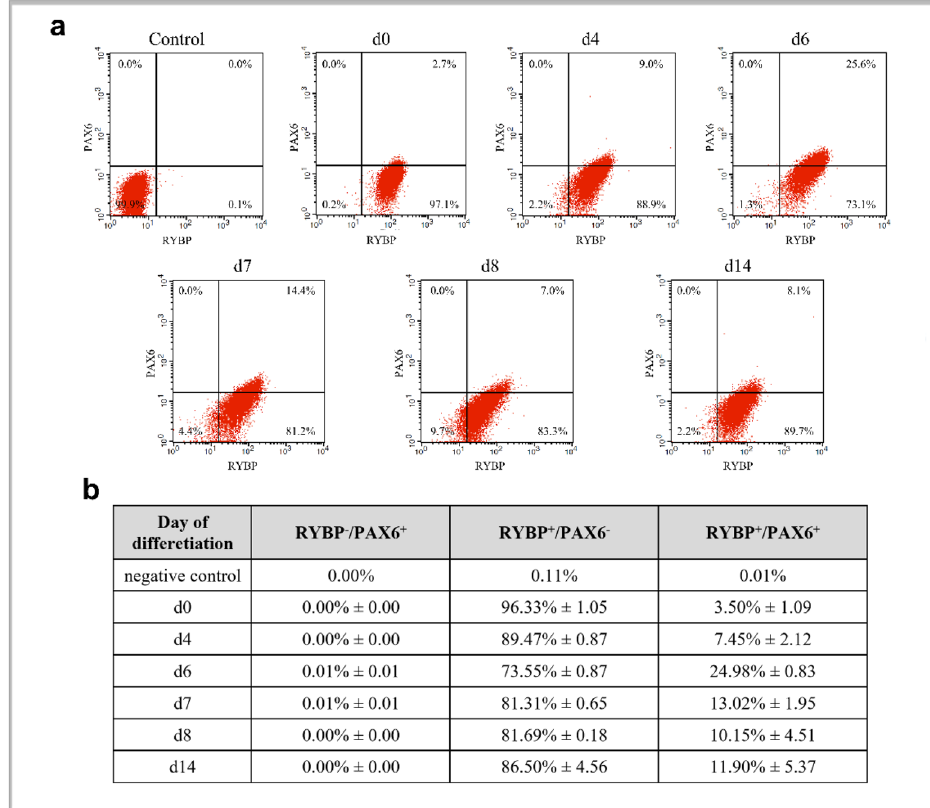
Figure 5. RYBP and PAX6 are co-expressed in cells during in vitro neural differentiation. The wild type ES cells were induced for differentiation with atRA for various periods of time (d4, d6, d7, d8 and d14) or left unstimulated (d0). The cells were stained with mouse monoclonal PAX6 and rabbit polyclonal RYBP/DEDAF primary antibodies followed with Alexa Fluor 647 labelled Donkey anti Mouse IgG (H + L) and Alexa Fluor 488 labelled Donkey anti Rabbit IgG (H + L), respectively then analyzed with cytofluorimetry. Control means, that the first antibodies were omitted and both secondary antibodies were added to the samples ( a , b ). Representative FACS plots of two independent experiments is shown at ( a ). Data are represented as means me of two biological repeats (n = 2). ( b ) Percentage and standard deviation ( ±) of control, RYBP − /PAX6 + , RYBP + /PAX6 − and RYBP + / PAX6 + cells during in vitro neural differentiation of the wild type ES cells. Percentages were calculated with BD CellQuest Pro Version 6.0